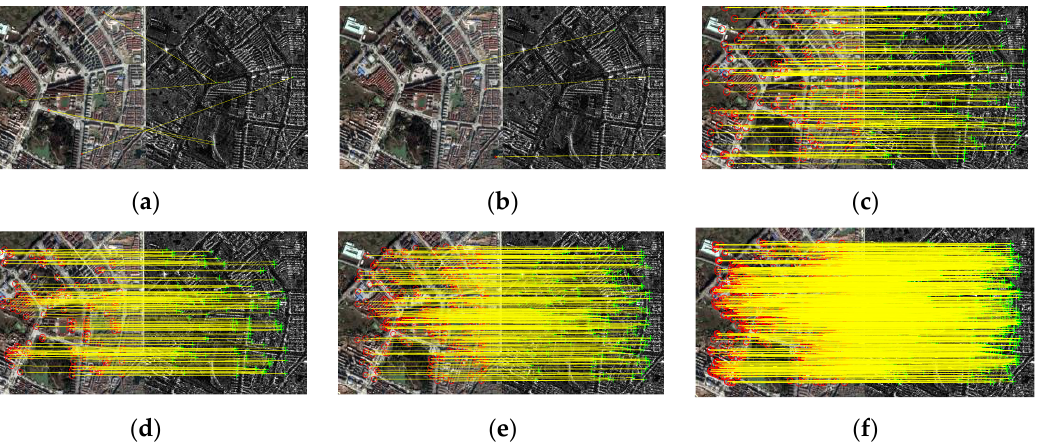
Figure 16. Experimental results of pair 4. The registration results from ( a ) to ( f ) are SIFT, SAR-SIFT, OS-SIFT, HOPC, RIFT, and MSPCO, respectively.